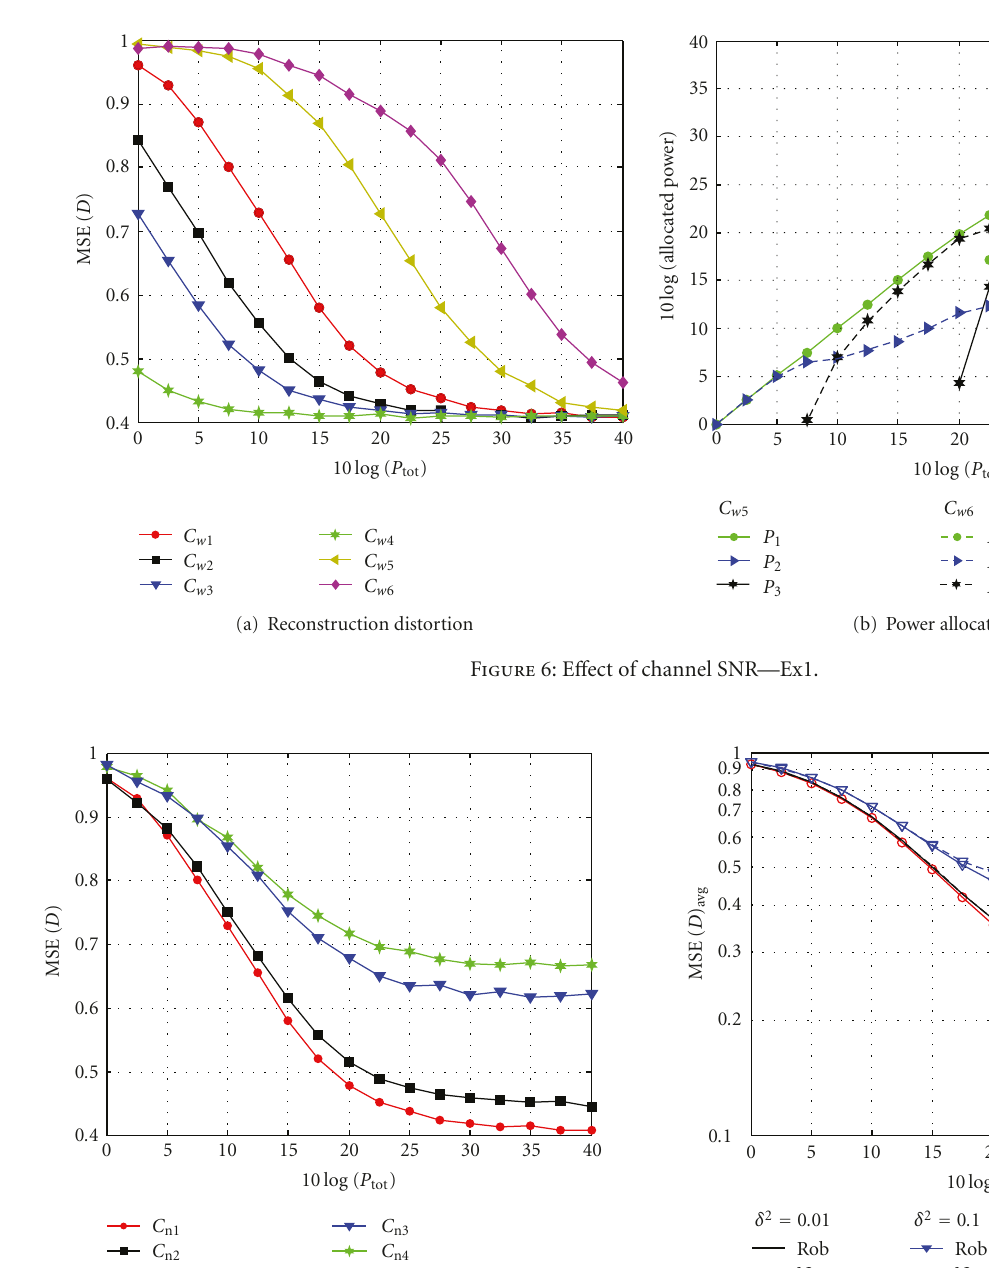
Figure 8: Comparison of perfect and imperfect